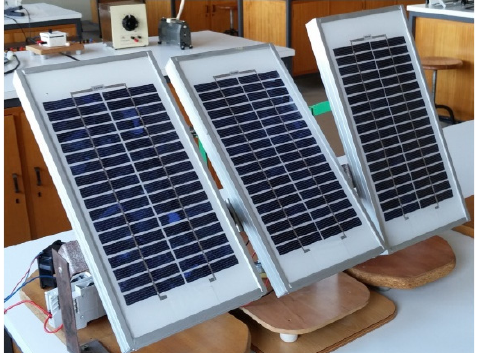
Figure 9. Photograph of the PV panels in which there is a vertical fault in the tracker of the right PV module.